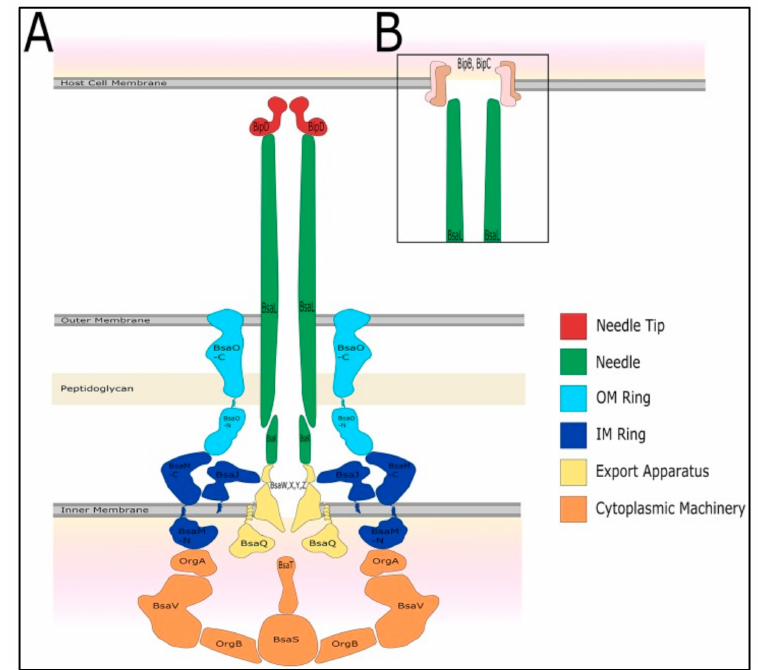
Figure 1. The predicted structure of the type III secretion system 3 (T3SS-3) of B. pseudomallei . Adapted with permission from [42]. Copyright © 2017 Vander Broek and Stevens. ( A ) The T3SS-3 comprises of cytoplasmic machinery, export apparatus, inner and outer membrane rings, needle, needle tip ( Burkholderia invasion protein D, BipD), and ( B ) translocon proteins ( Burkholderia invasion protein B, BipB and Burkholderia invasion protein C,